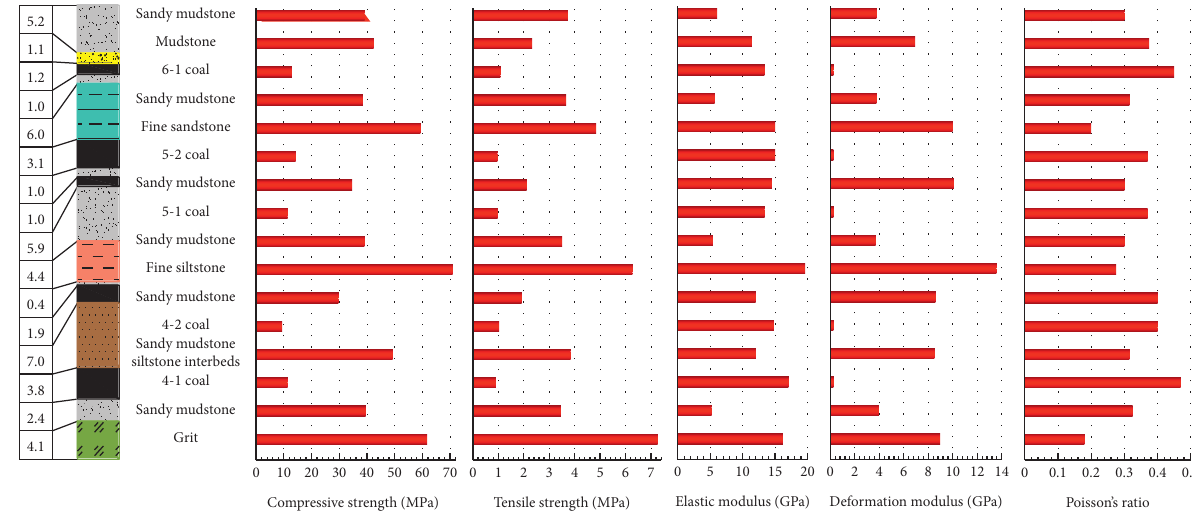
Figure 5: Physical and mechanical parameters of the roof and floor of the 12124 working face.